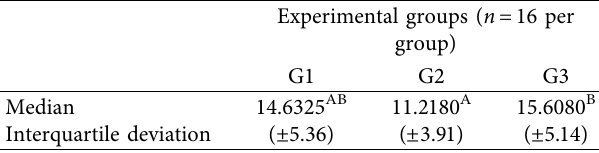
Table 2: Results of the experimental groups